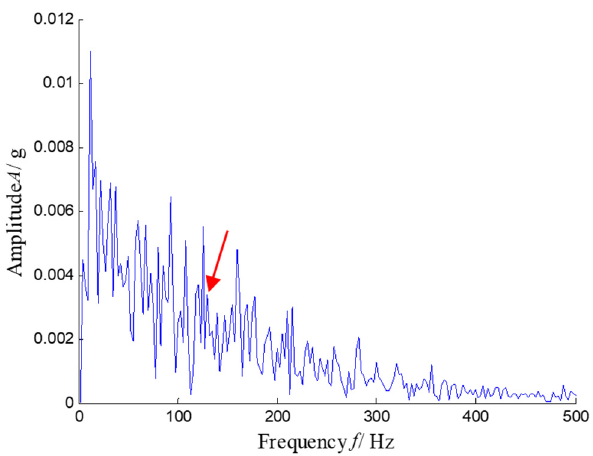
Figure 33. Envelope spectrum of the filtered signal.